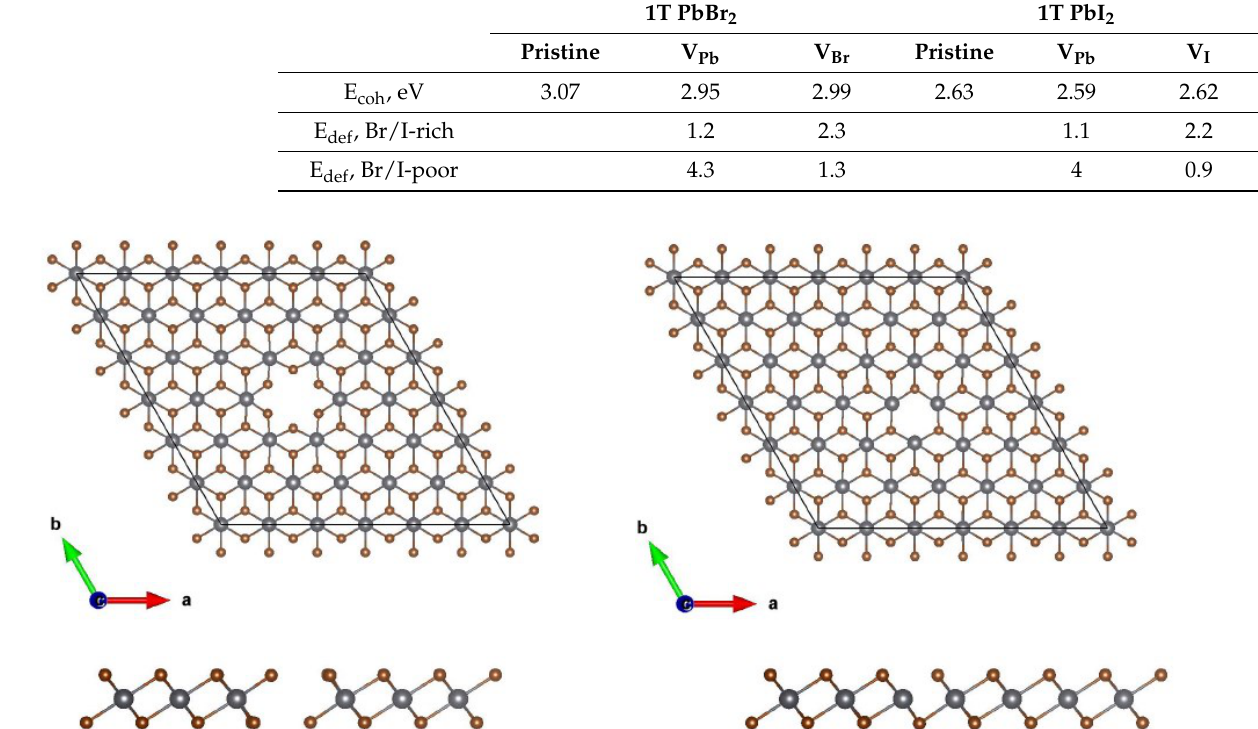
Figure 5. Left : top and side views of the Pb vacancy. Right : top and side views of Br vacancy. Pb and Br ions are shown by the grey and brown colours, respectively, a and b denotes crystal axys. The VESTA program was used for visualization [39]. Table 2. The cohesive and defect formation energies in charge neutral state for the PbBr 2 compared to PbI 2 (from Wang et al. [38]). All values are in eV.